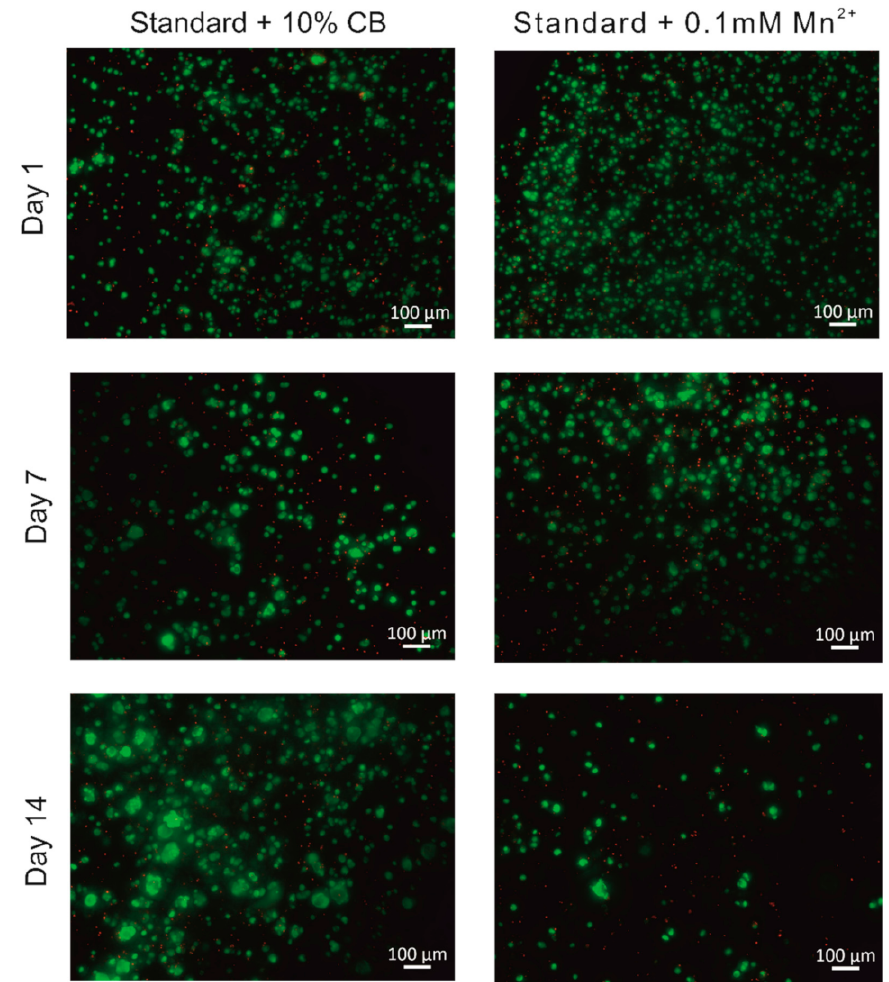
Figure 7. hADSCs encapsulated in alginate hydrogels with/without the addition of manganese. Fluorescent microscopy images of hydrogels extruded from 31G needle were obtained after live/dead staining at 1, 7, and 14 days of